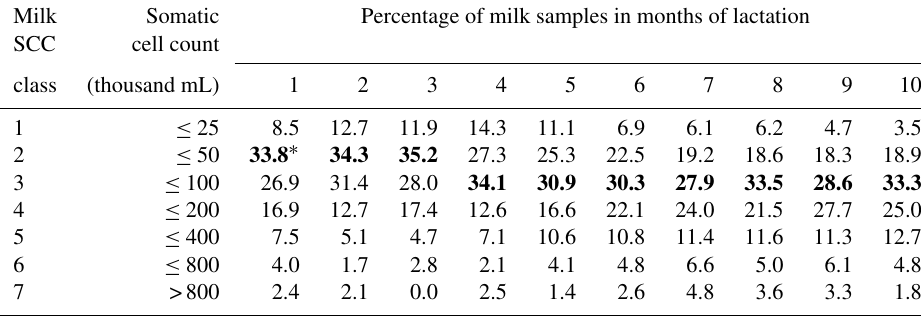
Table 3. Distribution of milk samples in terms of SCC classes in months of lactation. Milk Somatic Percentage of milk samples in months of lactation SCC cell count class